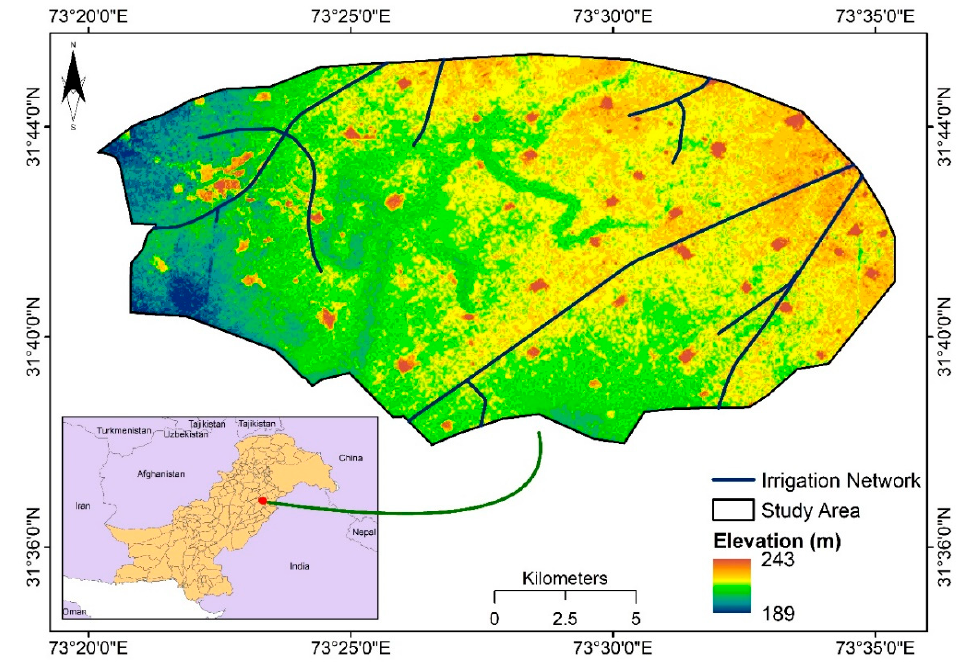
Figure 1. A location of the study area in Safdarabad Tehsil, Punjab.